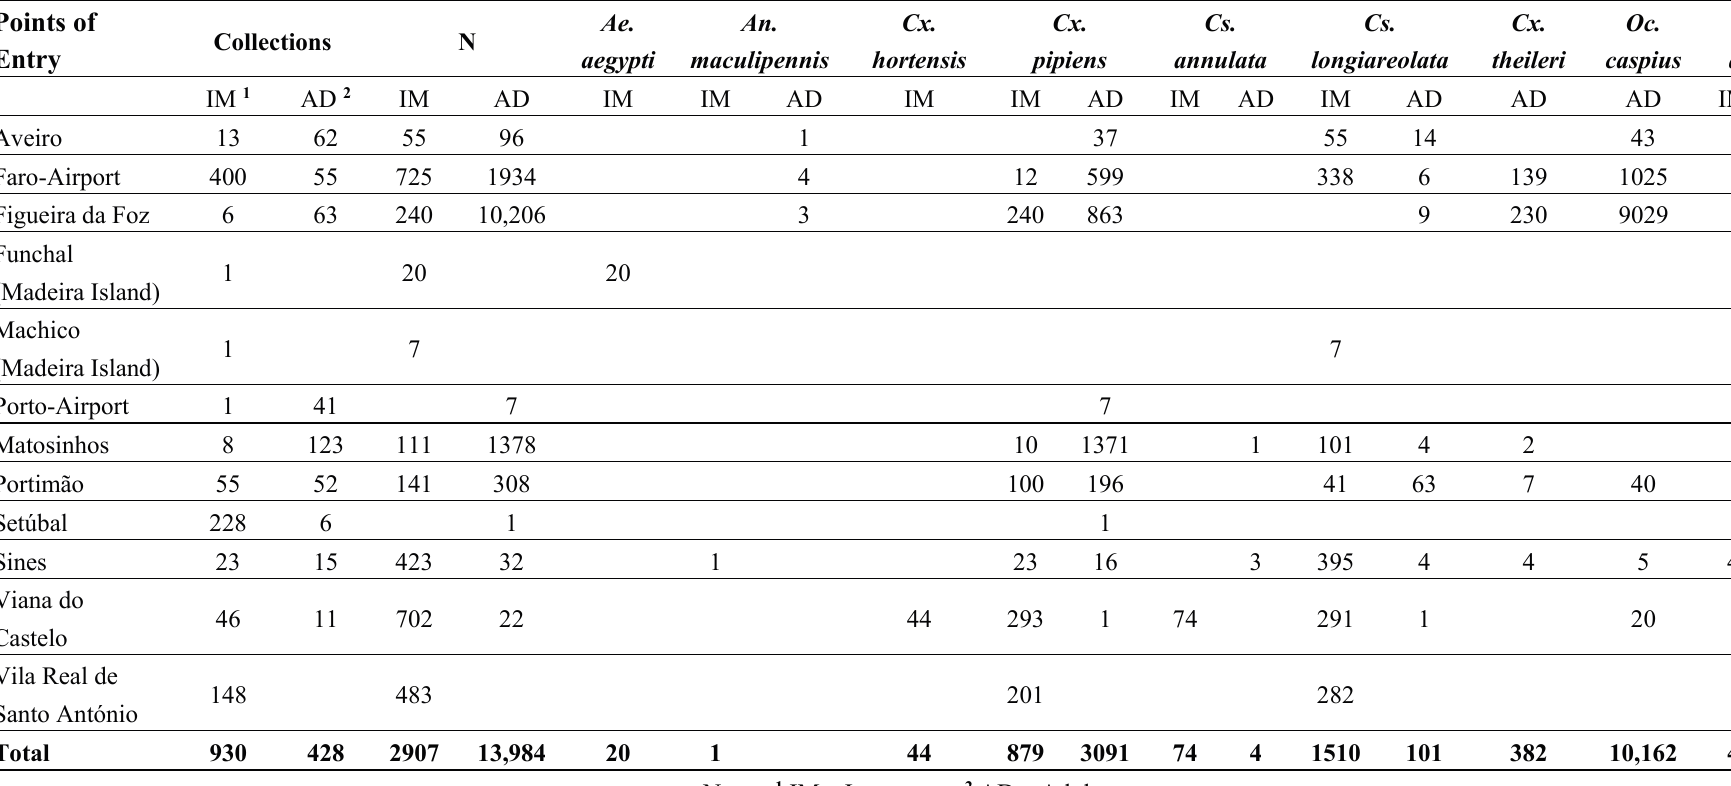
Table 3. Mosquito species identified in the frame of REVIVE in international maritime ports and